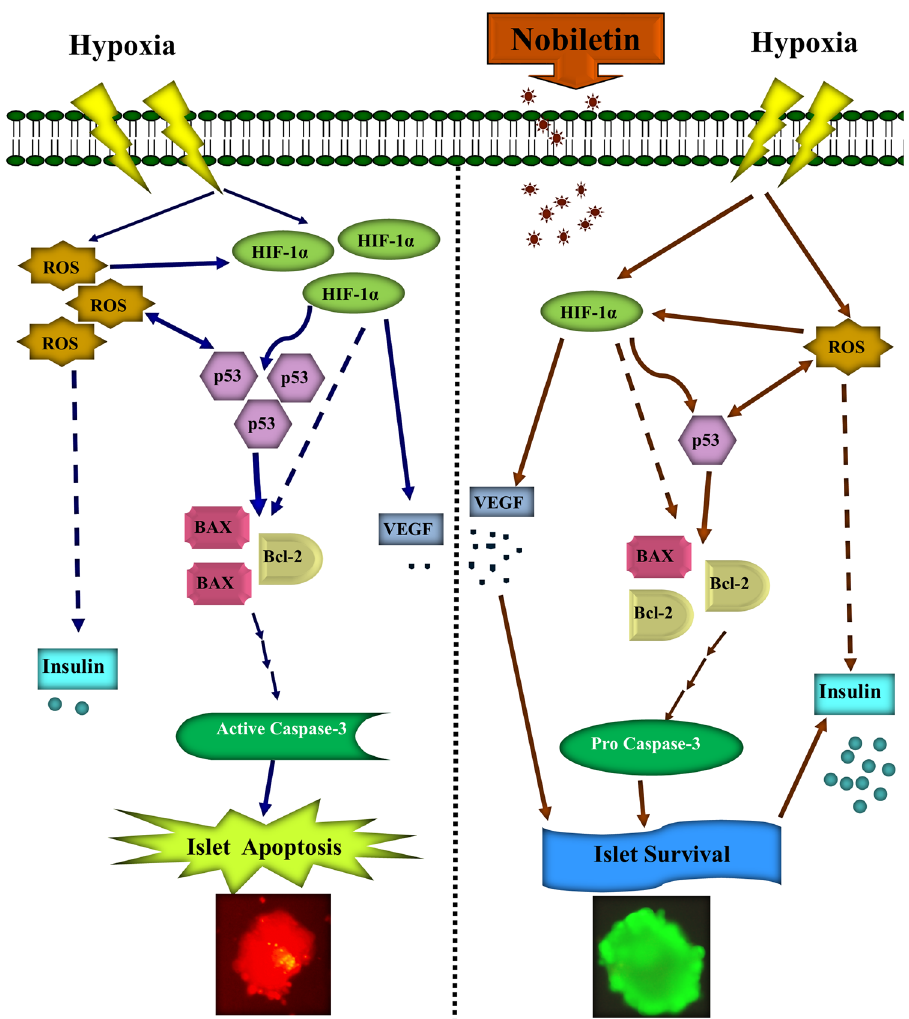
Figure 10. Schematic effect of nobiletin on human isolated islets in the culture. Nobiletin decreased hypoxia markers and oxidative stress induced apoptosis and improved islets survival and